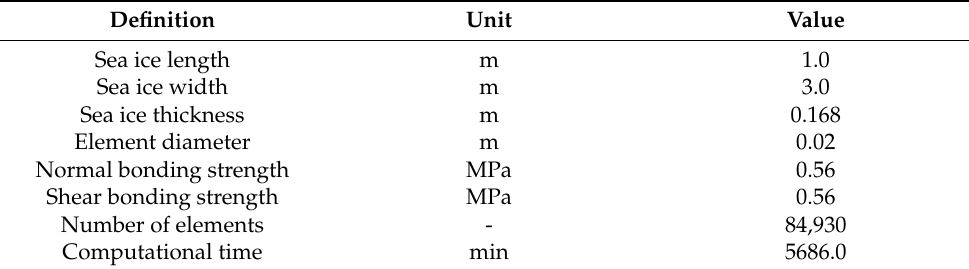
Figure 6. Interaction between sea ice and indenter: ( a ) Field test model [27]; ( b ) DEM simulation. Table 2. Discrete element parameters in the sea ice field test.